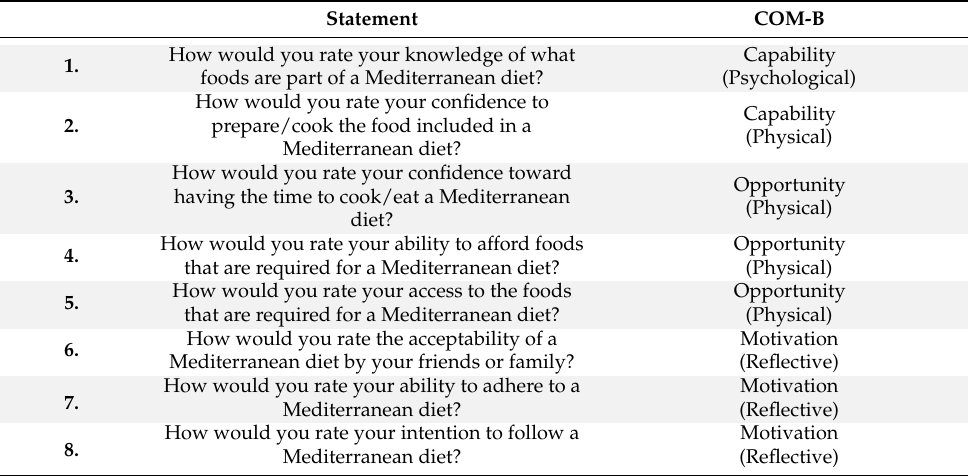
Table 5. Likert scale to evaluate participant confidence in MedDiet